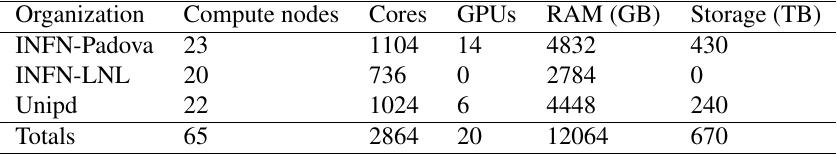
Table 1. CloudVeneto resources provided by the di ff erent organizations